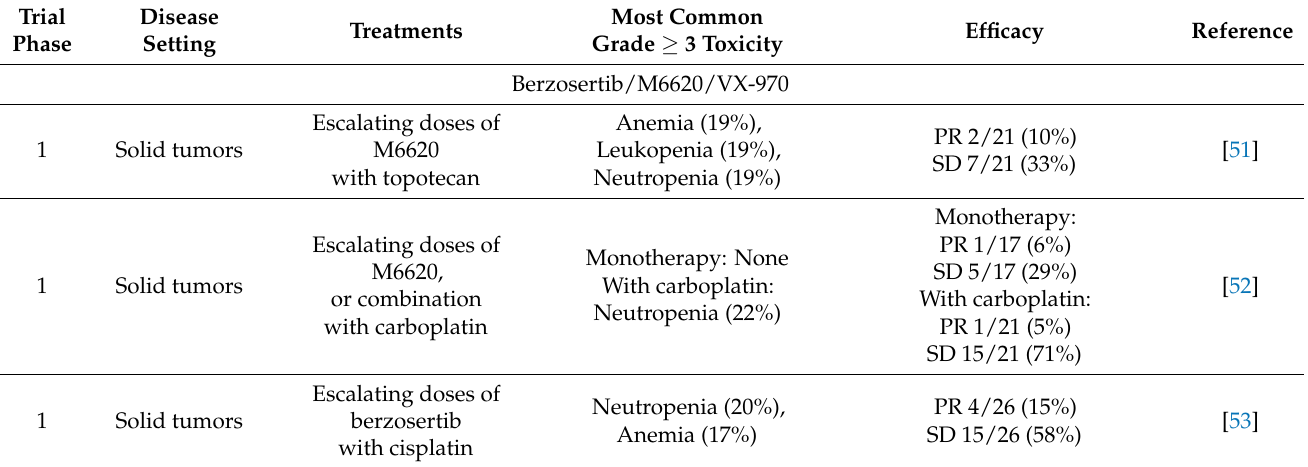
Table 1. Clinical trials of ATR